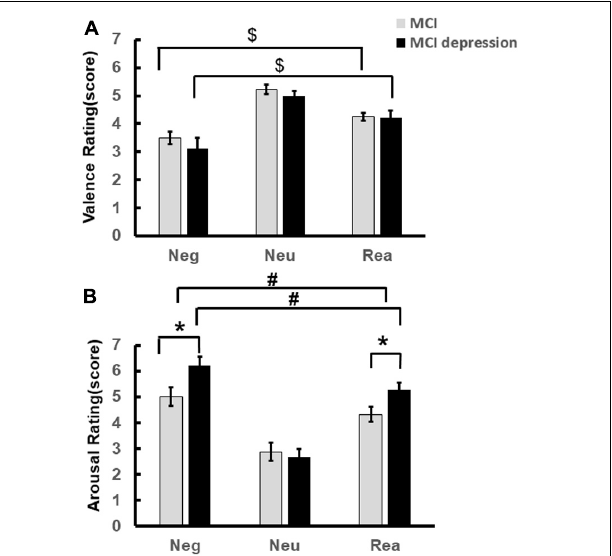
FIGURE 2 | Emotion Regulation task behavioral performance. (A) Demonstrates the valence scores difference during the Emotion Regulation task regarding negative, neutral reappraisal stimuli. (B) Demonstrates the arousal scores difference during the Emotion Regulation task regarding negative, neutral reappraisal stimuli. * p < 0.05, MCI vs. MCI depression (regarding arousal to negative and reappraisal stimuli); # p < 0.05, negative vs. reappraisal (regarding to the arousal scores); $ p < 0.05, negative vs. reappraisal (regarding to the valence